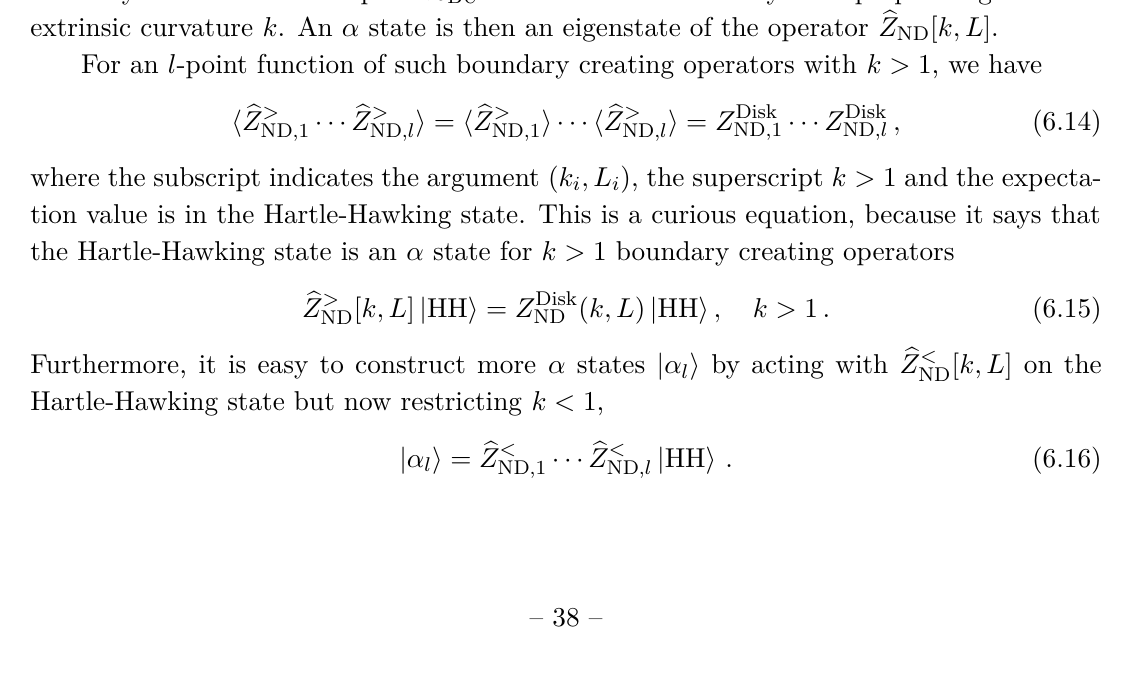
JHEP04(2021)069 Figure 6 . Contributions to two examples of gravitational density matrices. The lighter green boundaries indicate the ket and the darker ones the bra. In the top row we indicated the contribu- tions to the density matrix associated to the Hartle-Hawking state ( ρ = | Ψ Ψ ) for k < 1 HH HH i h HH | and k > 1 . In the latter case, any topology other than the disk contributes as long as there are no bra-ket wormholes (wormholes connecting the ket and bra). In the bottom row, we indicated what topologies contribute to the Page density matrix. The situation is similar in the top row; however, since the Page state allows bra-ket wormholes, there can be topologies connecting the bra and ket. Notice that ρ = ρ for k < 1 , whereas they are unequal for k > 1 due to the appearance HH Page of bra-ket wormholes. In each geometry, we have indicated the gluing of the Lorentzian with the Euclidean section with a small green